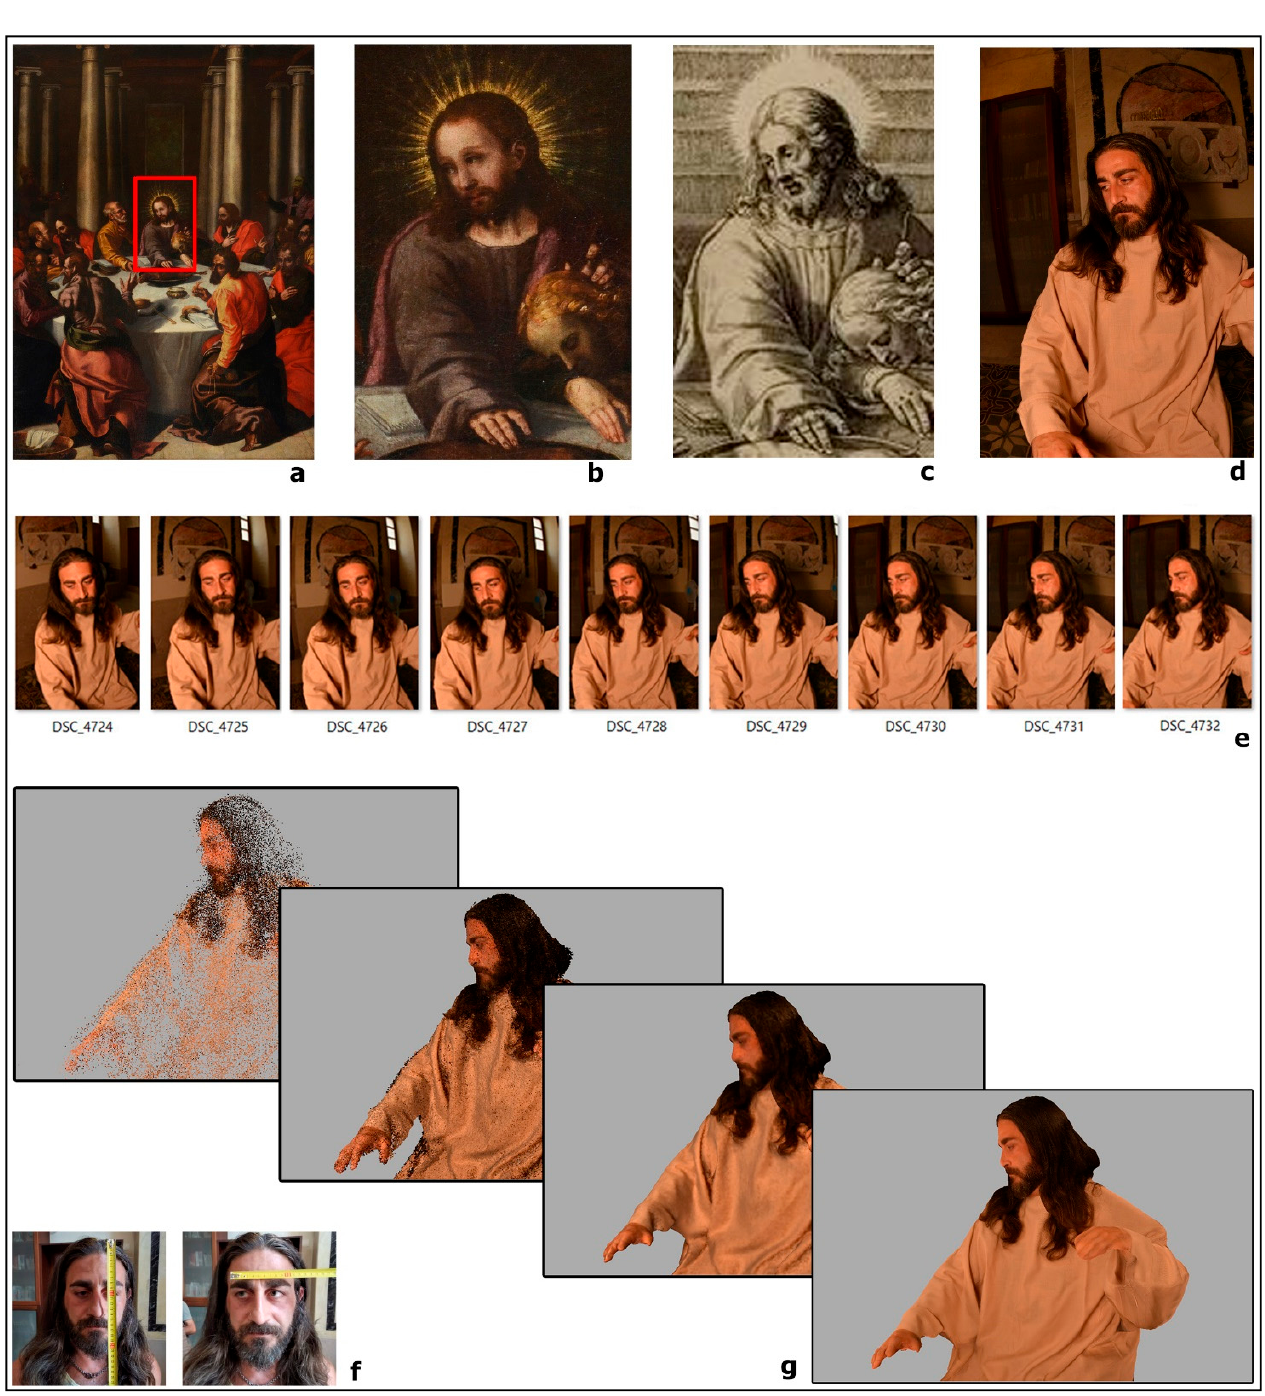
Figure 9. ( a ) Gaspar Hovic, “Last Supper”, 1583–1593(?); ( b ) Gaspar Hovic, “Last Supper”, 1583–1593(?), detail of Christ; ( c ) Cornelius Cort, “Last Supper”, 1578, detail of Christ; ( d ) actor who portrays the Christ; ( e ) sequences of photographic shots; ( f ) survey of two measures for the scaling of the virtual character; ( g ) processing from the point cloud to the textured character.